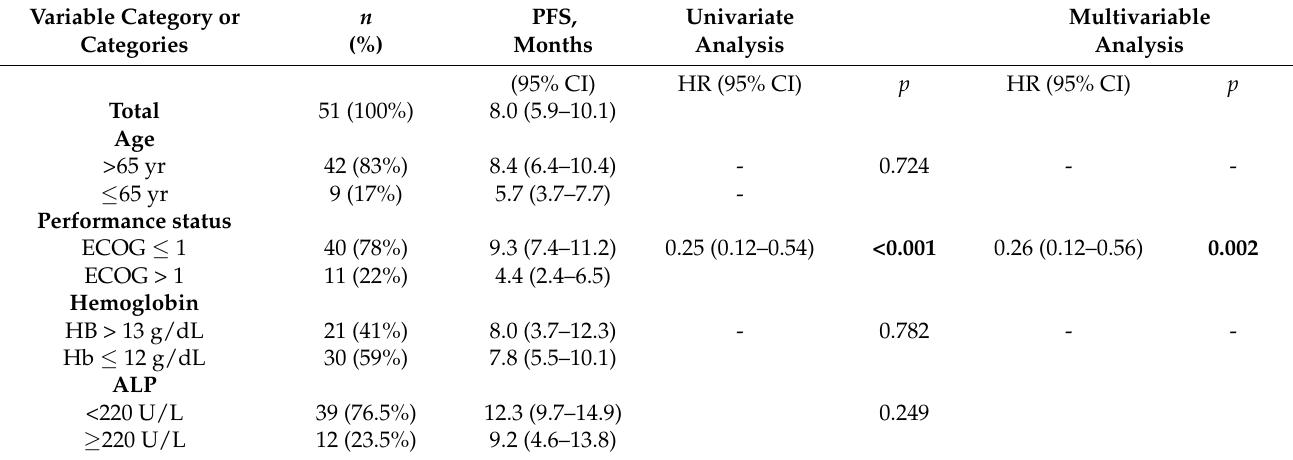
Table 2. Relationship of PFS with selected factors in patients with mCRPC treated with 177 Lu-PSMA-617. Variable Category